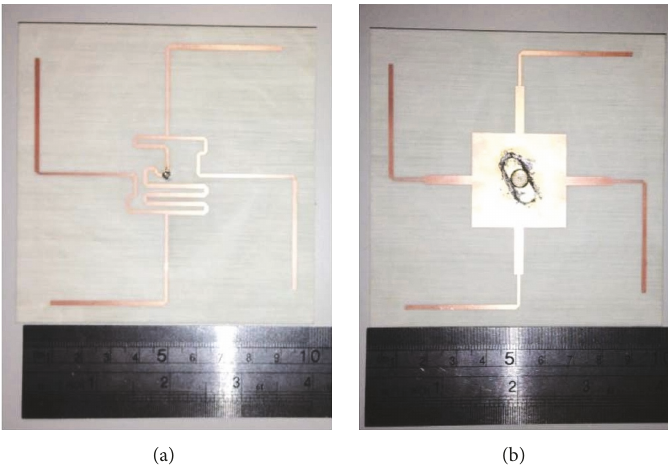
Figure 2: CP antenna with phase shifter. (a) Front view and (b) rear view [39].